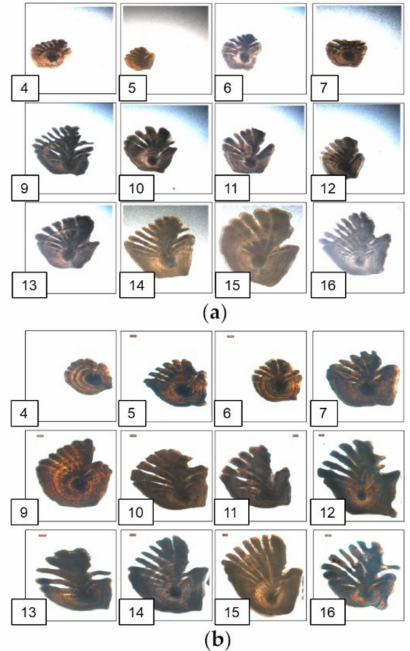
Figure 1. Examples of otolith images (resized to 224 × 224 pixels) corresponding to different ages (4–16 years) predicted by human readers. ( a ) Images acquired and annotated by the Norwegian lab; ( b ) Images acquired and annotated by the Icelandic